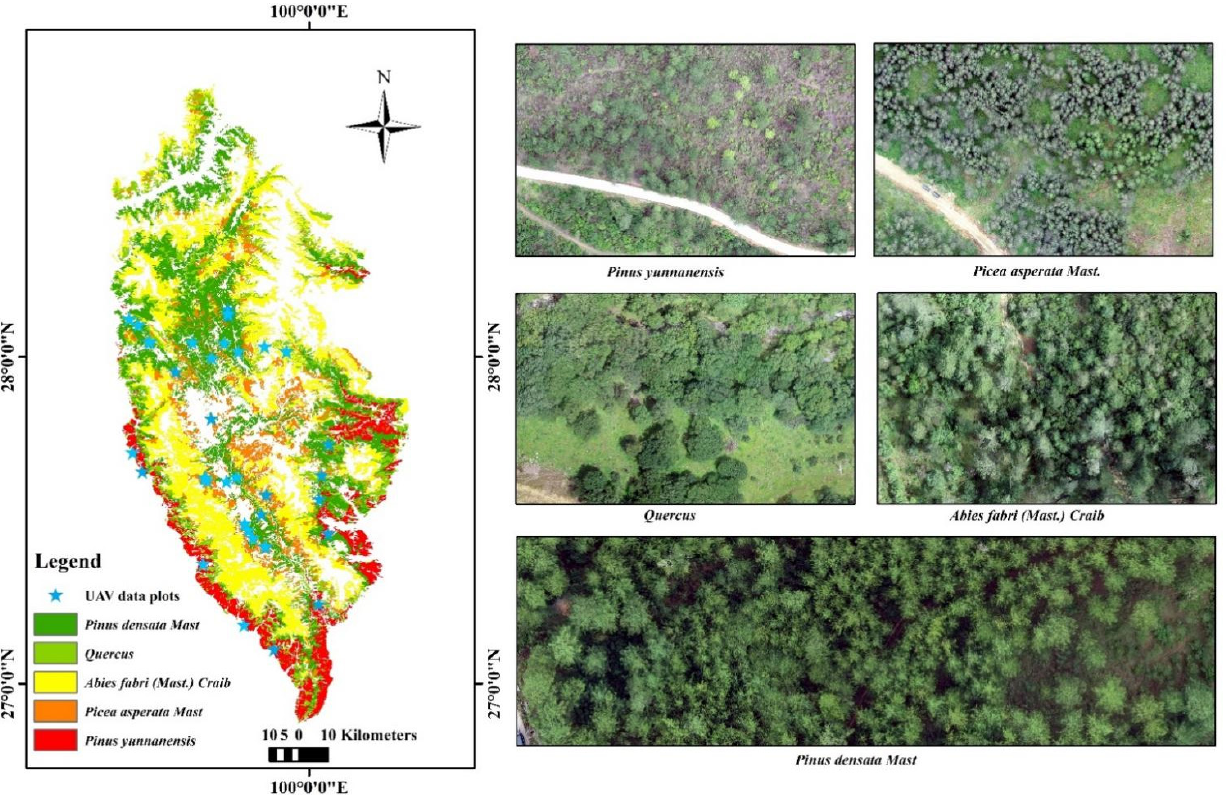
Figure 2. The location of UAV survey plots and the orthophoto of four tree